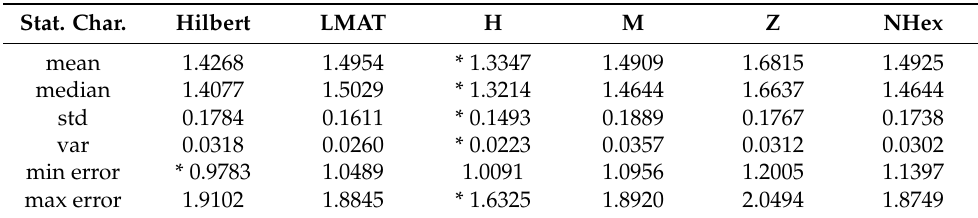
Table 3. Statistical characterization of all mobile path planning models in terms of localization error for